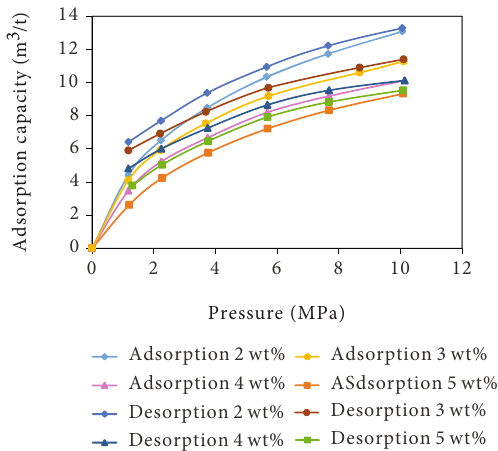
Figure 4: Methane isothermal adsorption/desorption curves of coal with di ff erent water contents.